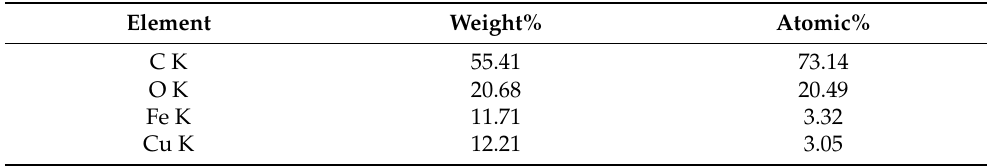
Table 1. Element content of RGO-coated CuFeO 2